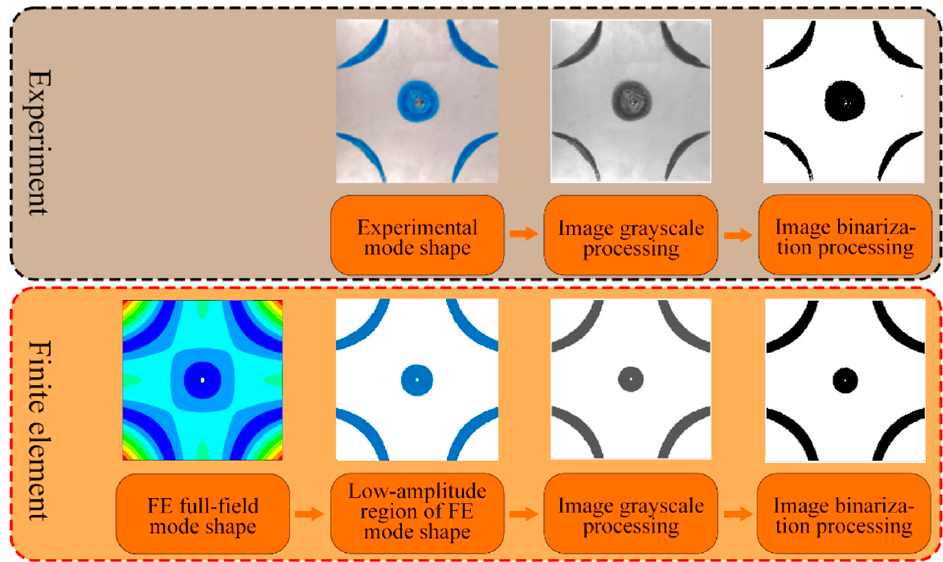
Figure 7. Image unification process of the FE and experimental mode shapes. After unifying the mode shapes, the binarized images of the FE and experimental mode shapes are obtained. In a broad sense, the binarized image can be regarded as a binarization matrix. Therefore, the image-similarity-recognition problem is transformed into a matrix-similarity-recognition problem. Moreover, since the binarization matrix is composed only of 0 and 1, the effect of the element points in the image on the similarity recognition result is weakened, and the shape of the pattern in the image becomes the main factor that determines the similarity-recognition accuracy. The calculation process of the mode-identification index ISR refers to the MAC equation (proposed by Allemang [19]). First, the binarization matrices of the FE and experimental mode shapes are tiled into a vector form. Subsequently, the ISR can be calculated according to the following expression: